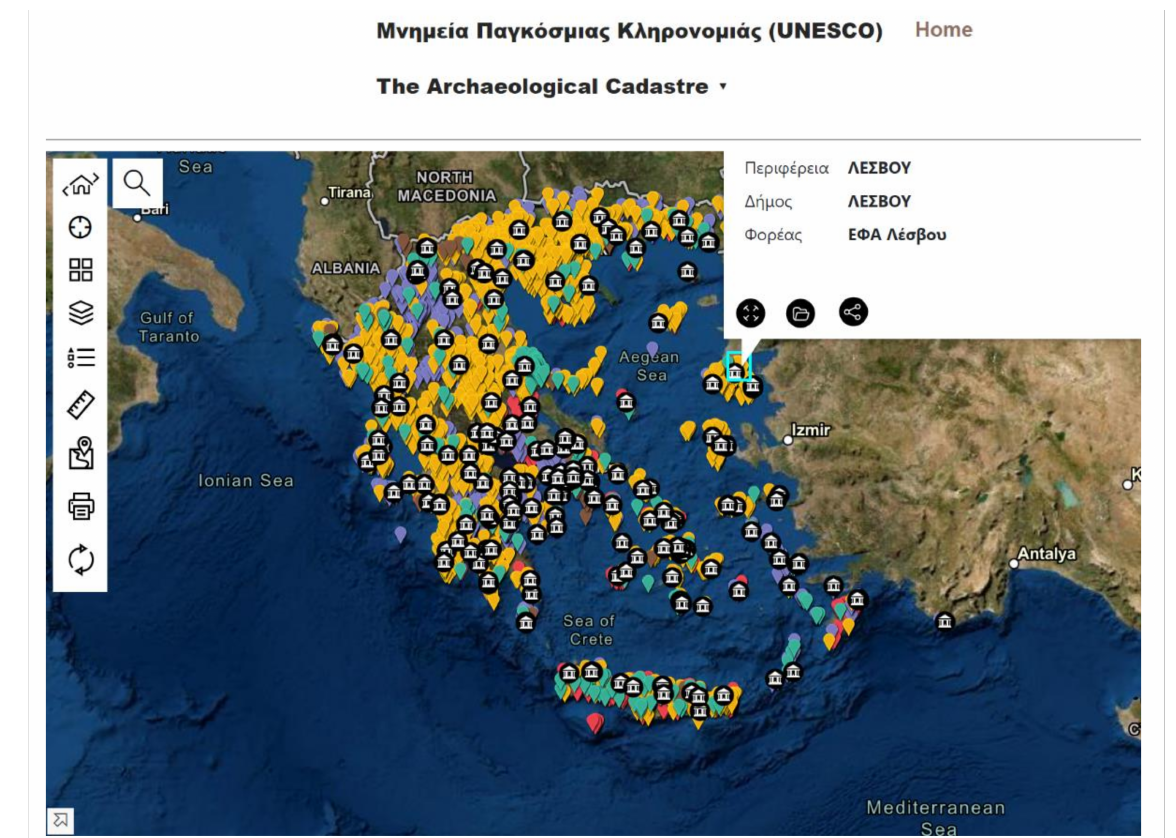
Figure 5. Greece The Archaeological Cadastre Portal: screenshot showing different types of monu- ments and archaeological